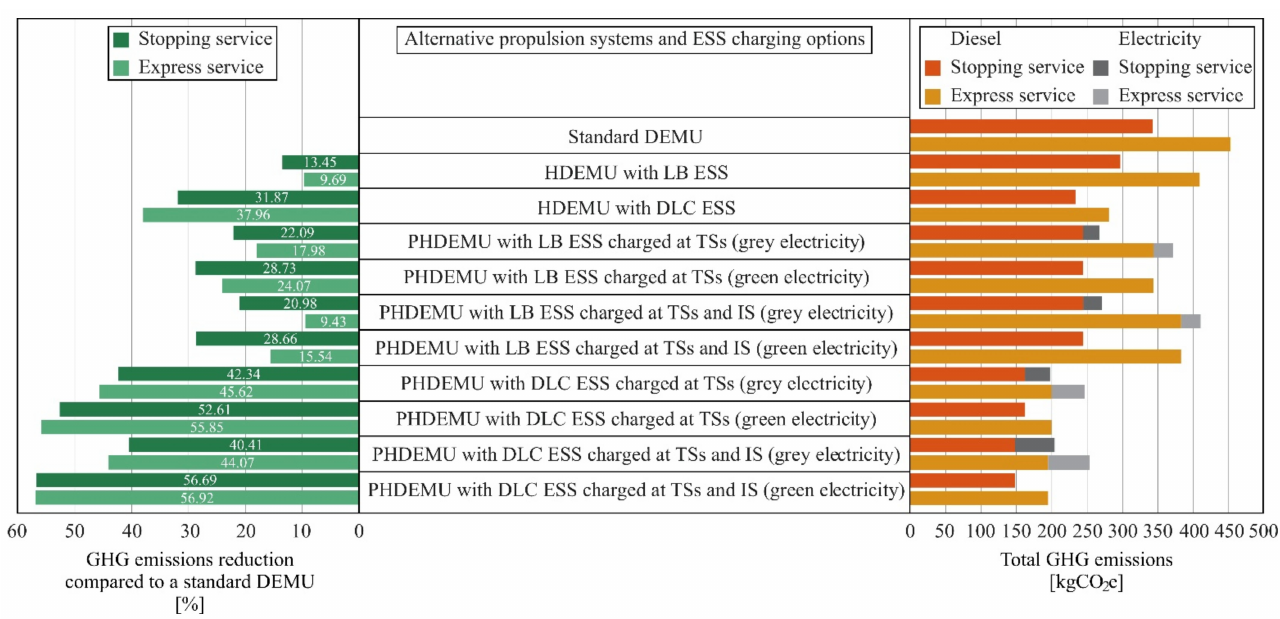
Figure 9. Total GHG emissions depending on the propulsion system, charging location, and electricity production configu- rations; and estimated potential reduction compared to a standard diesel-electric multiple unit.